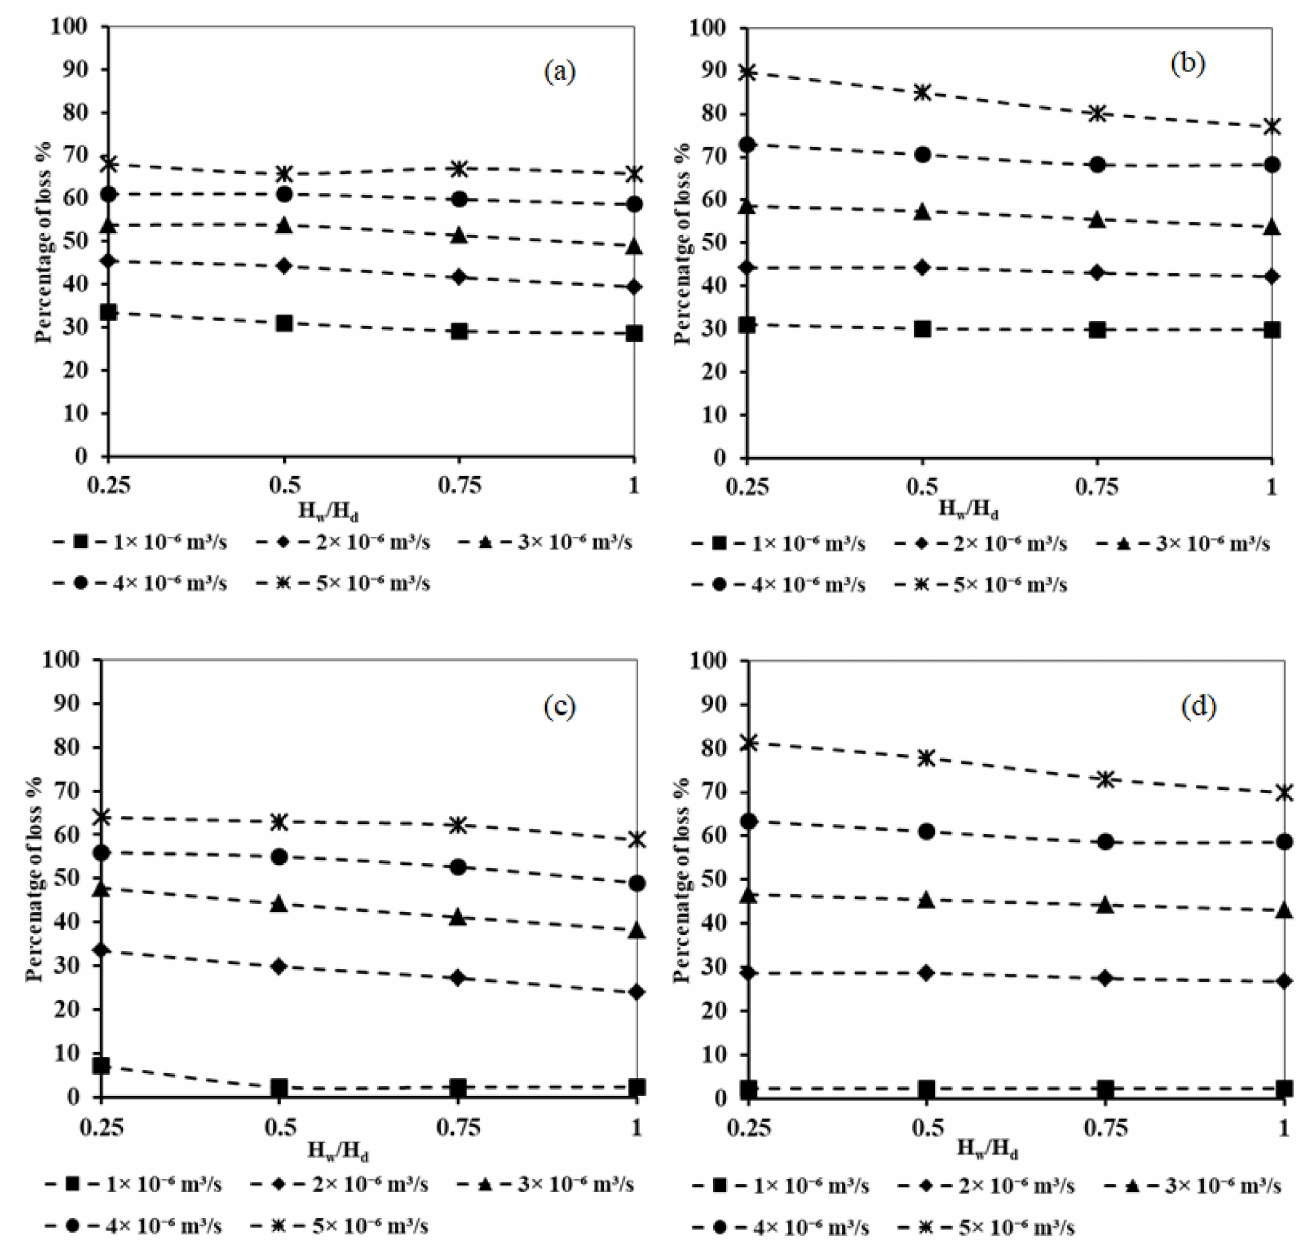
Figure 7. Relation between well height ratio and loss of subsurface dam effectiveness for L d = 0.50 m and D f = 0.005 m for: ( a ) L w /L d = 1.0 and H F = 0.1, ( b ) L w /L d = 2.0 and H F = 0.1, ( c ) L w /L d = 1.0 and H F = 0.2, ( d ) L w /L d = 2.0 and H F = 0.2. Increasing the dimensionless well height ratio from 0.25 to 1.0 resulted in a slight decrease in the loss of effectiveness of the subsurface dam due to fracture and